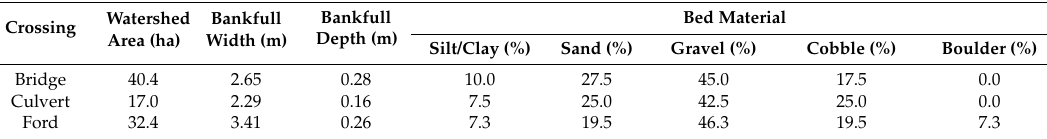
Table 1. Stream characteristics by crossing structure installed. Watershed area measured from crossing location. Stream slope, bankfull width, and depth measured immediately upstream of installed crossing location. All three crossing locations had a streambed slope of 2%. Streambed material composition based on 40 bed material samples.